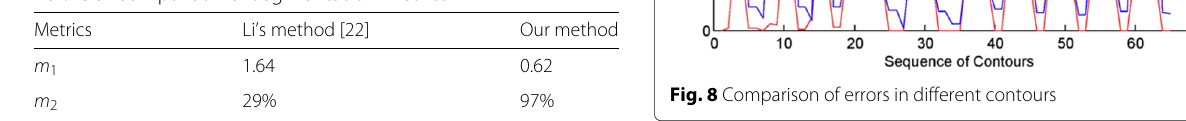
Table 5 Comparison of segmentation metrics